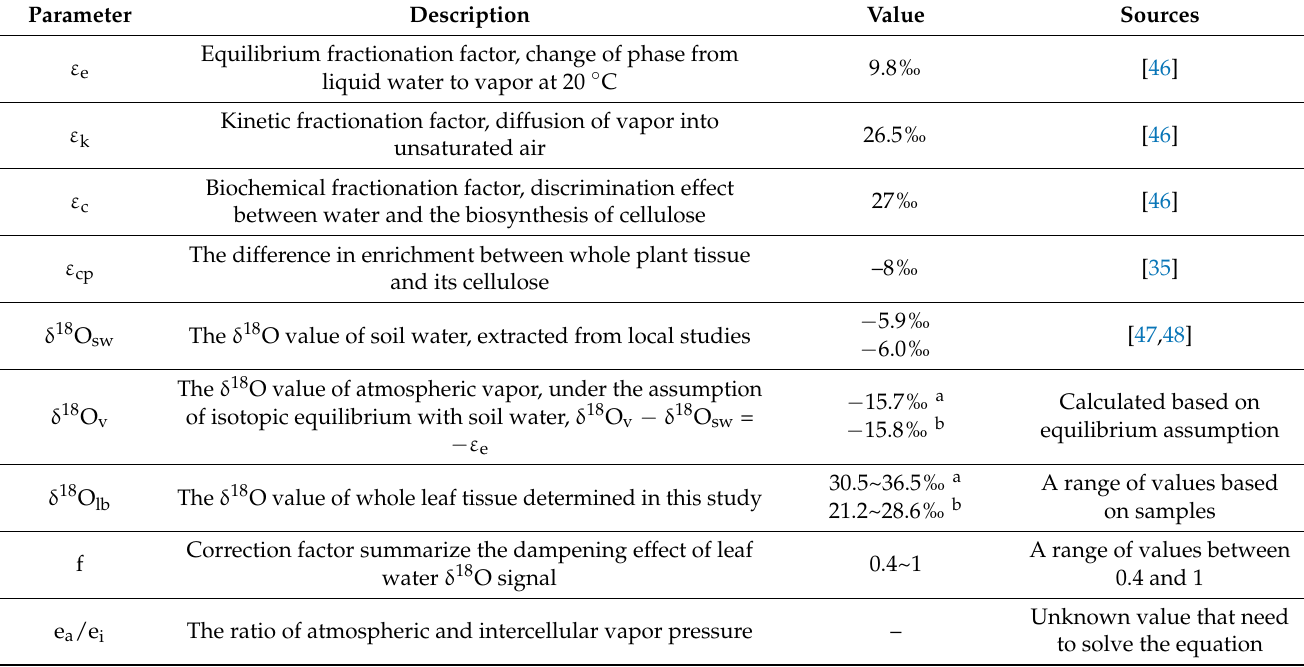
Table 3. Summary of parameters in Equations (2) and (3). (Note: a : for Beijing samples. b : for Shenzhen